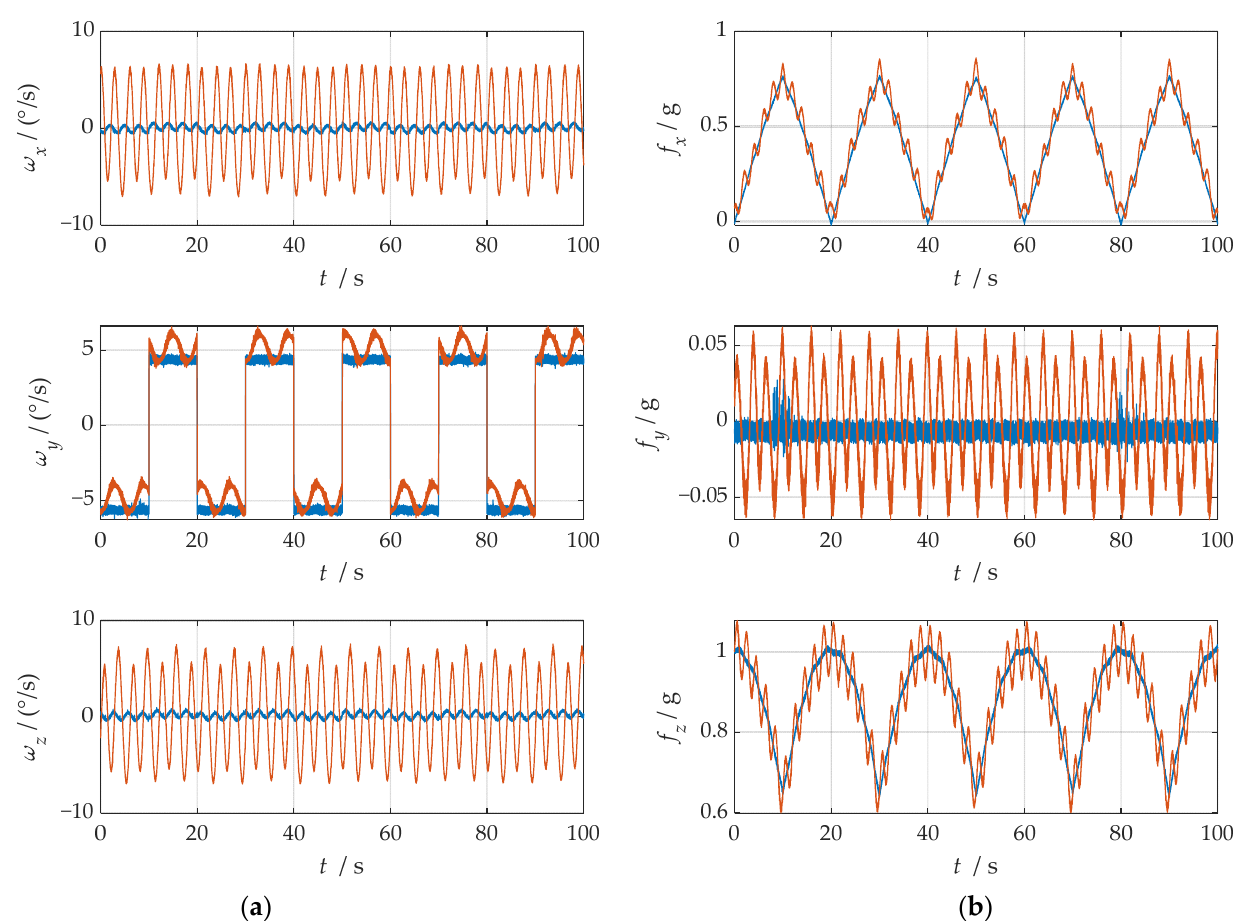
Figure 25. Ideal attitude solution results: ( a ) ideal results of yaw angle; ( b ) ideal results of roll angle; ( c ) ideal results of pitch angle.